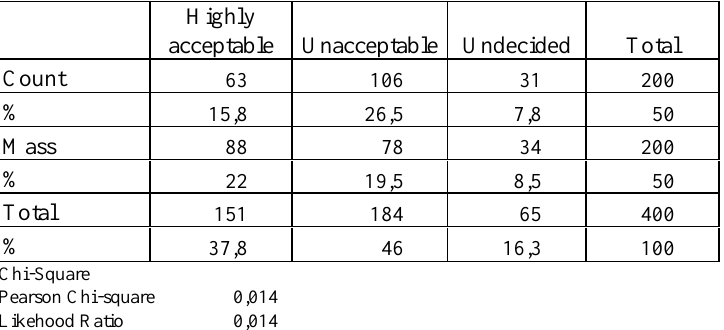
Table I: Crosstab between count/ mass vs. judgment of the first experiment Highly